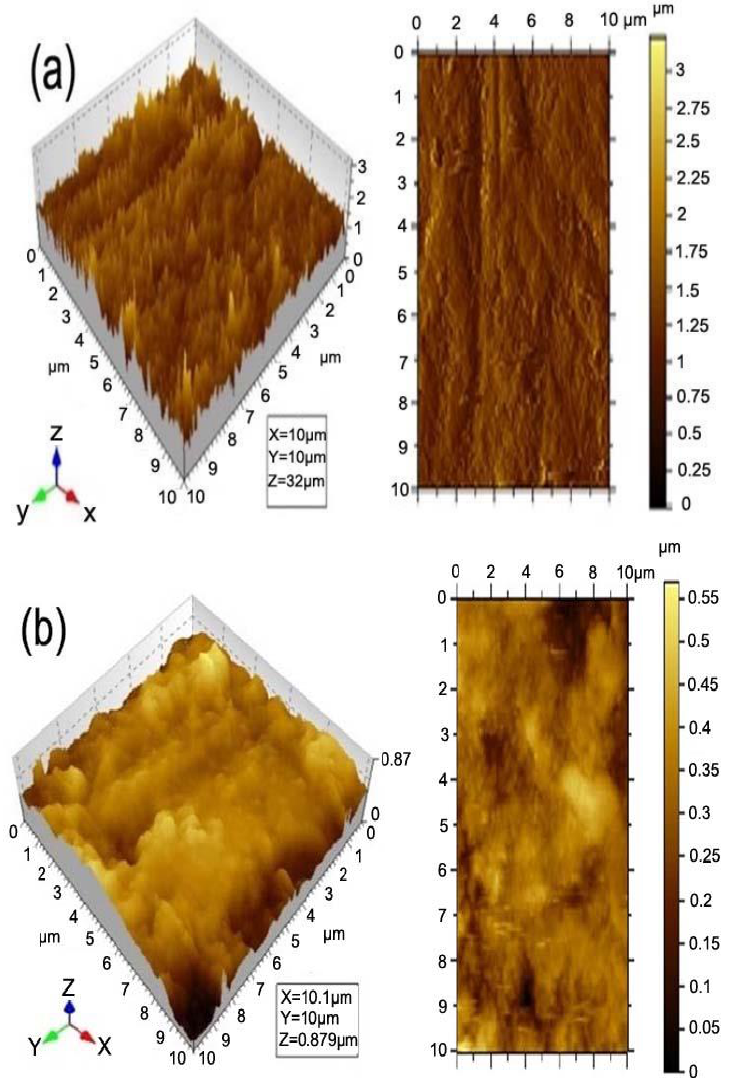
Figure 10. AFM micrographs of the eroded surfaces of the coated specimens at lower and higher impact angles. ( a ) Velocity: 30 m/s, angle: 35 ◦ , distance: 45 mm, erodent discharge: 1500 g/min; impact angles. ( a ) Velocity: 30 m/s, angle: 35°, distance: 45 mm, erodent discharge: 1500 g/min; ( b ) velocity: 50 m/s, angle: 95°, distance: 45 mm, erodent discharge: 1500 g/min. ( b ) velocity: 50 m/s, angle: 95 ◦ , distance: 45 mm, erodent discharge: 1500